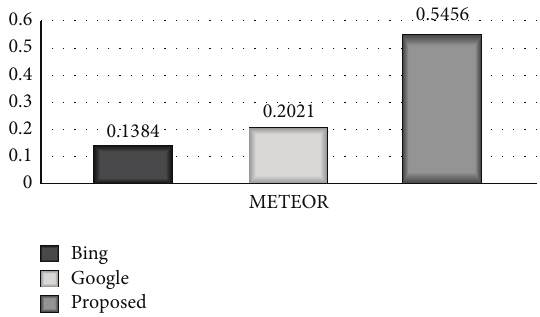
Figure 5: Comparative bar diagram among proposed system, Google, and Bing based on ROUGE-L scale.